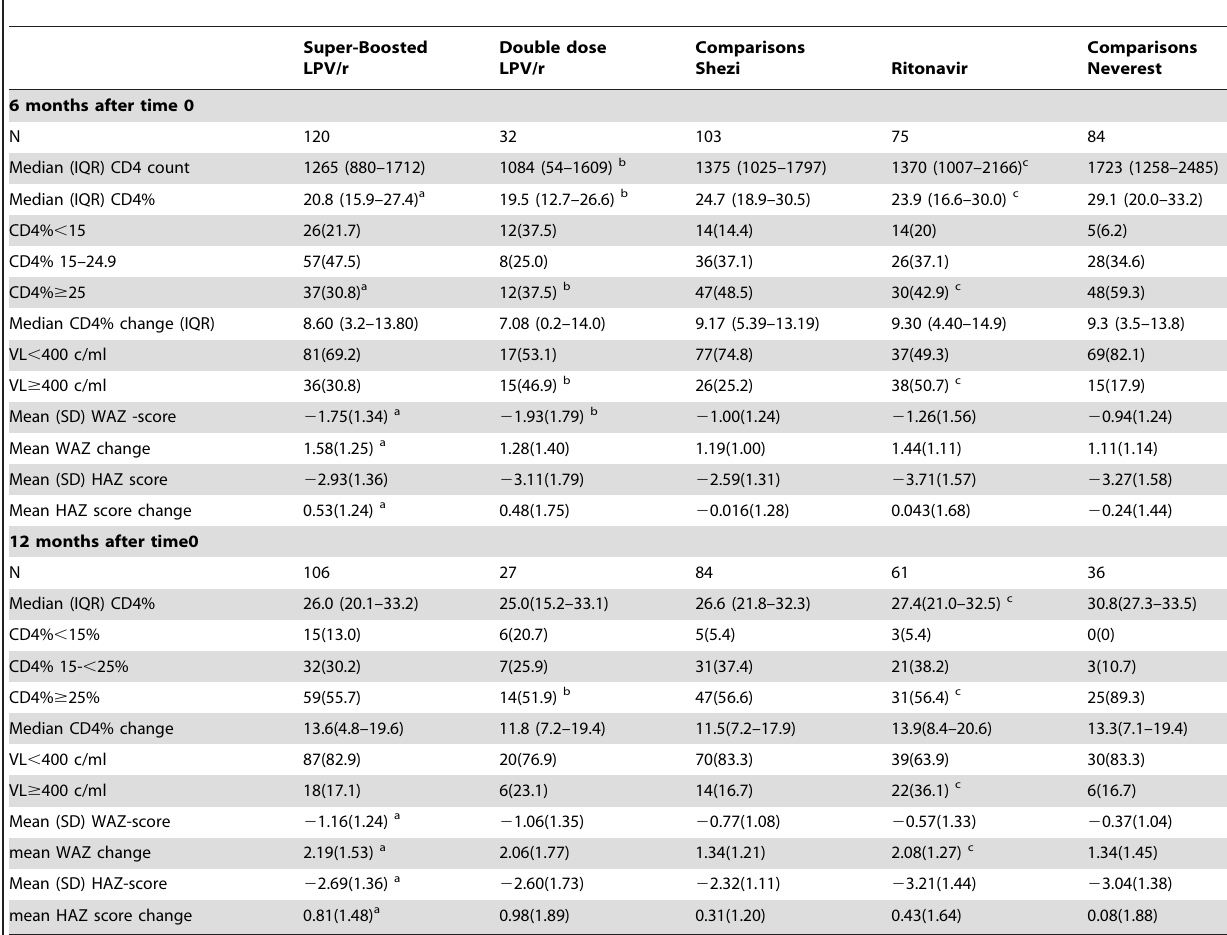
Table 4. Virologic, clinical and immunological outcomes at 6 and 12 months between children co-treated for TB stratified by the modifications made to their PI-based regimen and comparisons not co-treated for